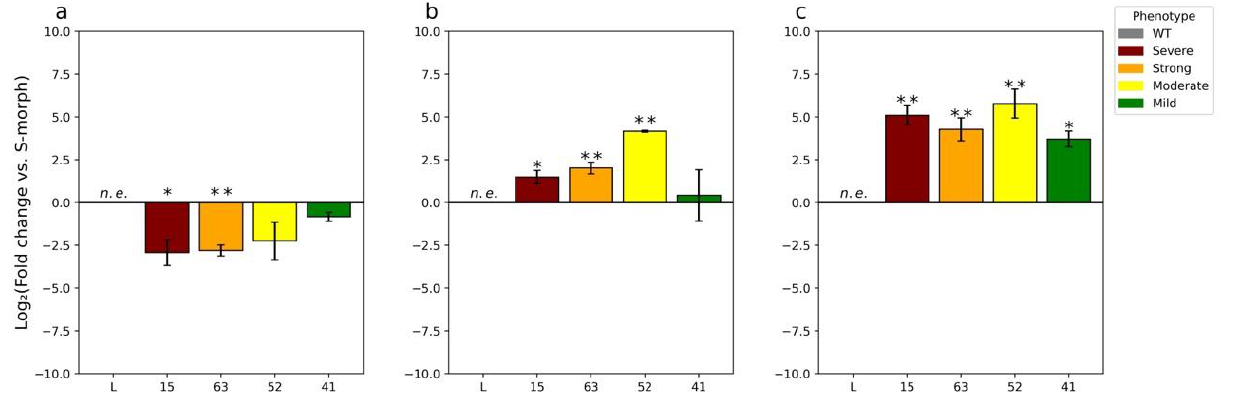
Figure 3. RT-qPCR analysis of the expression of TjYUC6 in T 0 lines compared to WT S-morph during: early floral development ( a ), late floral development ( b ), and the pollen from dehisced anthers ( c ). N = 3 biological replicates, n.e. = not expressed, * = p -value < 0.05, and ** = p -value < 0.01. p -values determined by Student’s t -test comparing the ∆ CT of the respective transgenic line with that of the WT S-morph. Error bars represent the standard error of the fold change. Values represent the log2 (fold change).